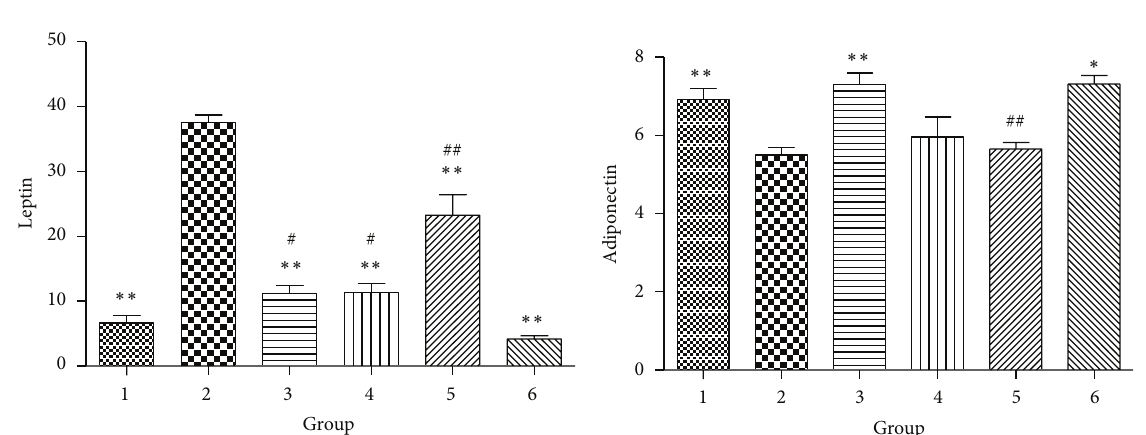
Figure 2: Levels of lectin and adiponectin ( ∗ 𝑃 < 0.05 compared with Group 2. ∗∗ 𝑃 < 0.01 compared with Group 2; # 𝑃 < 0.05 compared with Group 1. ## 𝑃 < 0.01 compared with Group